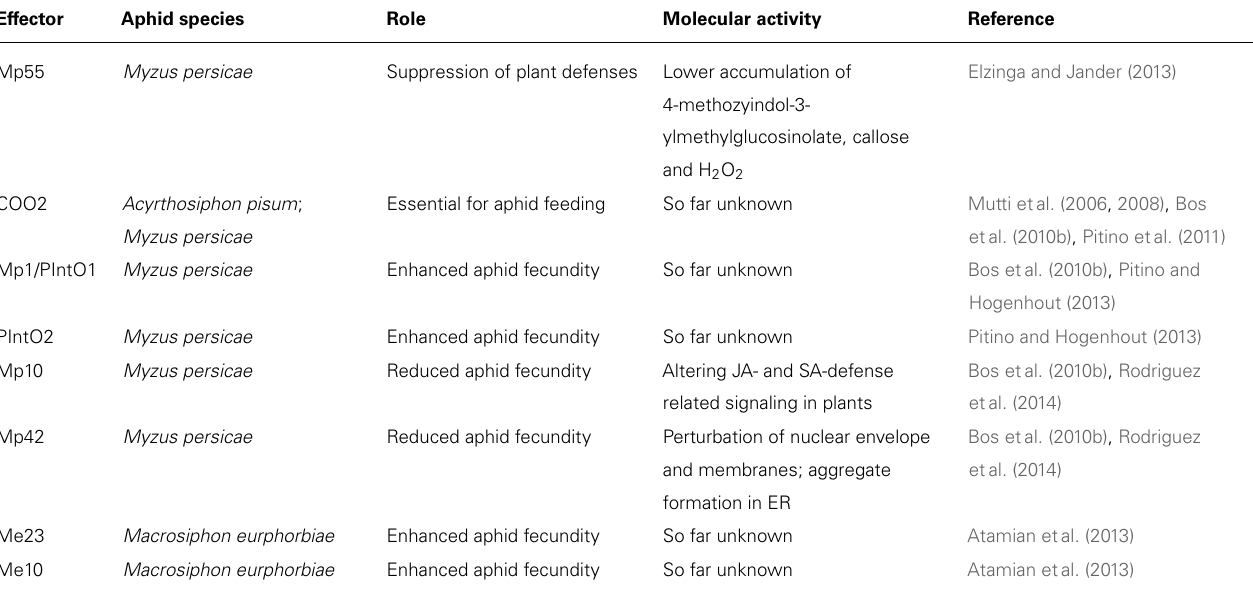
Table 1 | Summary of currently characterized aphid effector